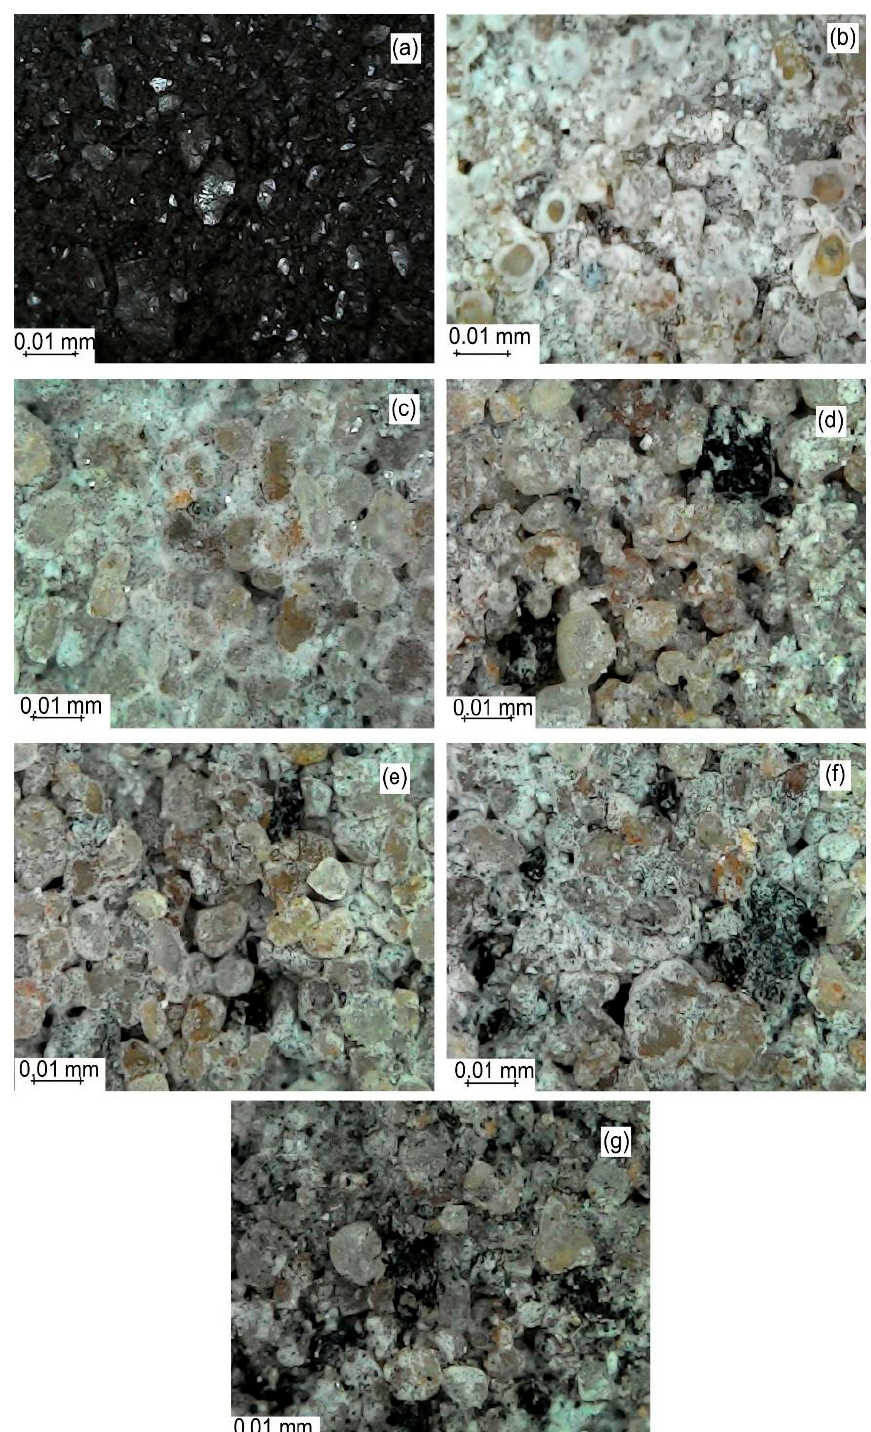
Figure 2. Surface images of the ( a ) thermal treated A. aculeata endocarp (AE) and cross-section of Portland cement composite (PC)/AE composites with ( b ) 0, ( c ) 5, ( d ) 10, ( e ) 15, ( f ) 20, and ( g ) 50 wt% AE.